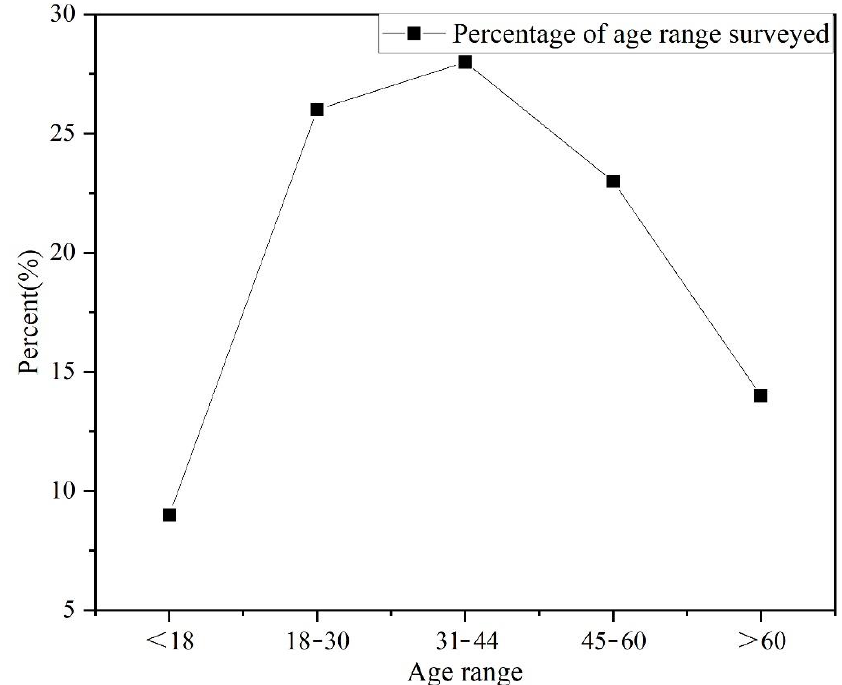
Figure 2. Percentage chart of respondent age